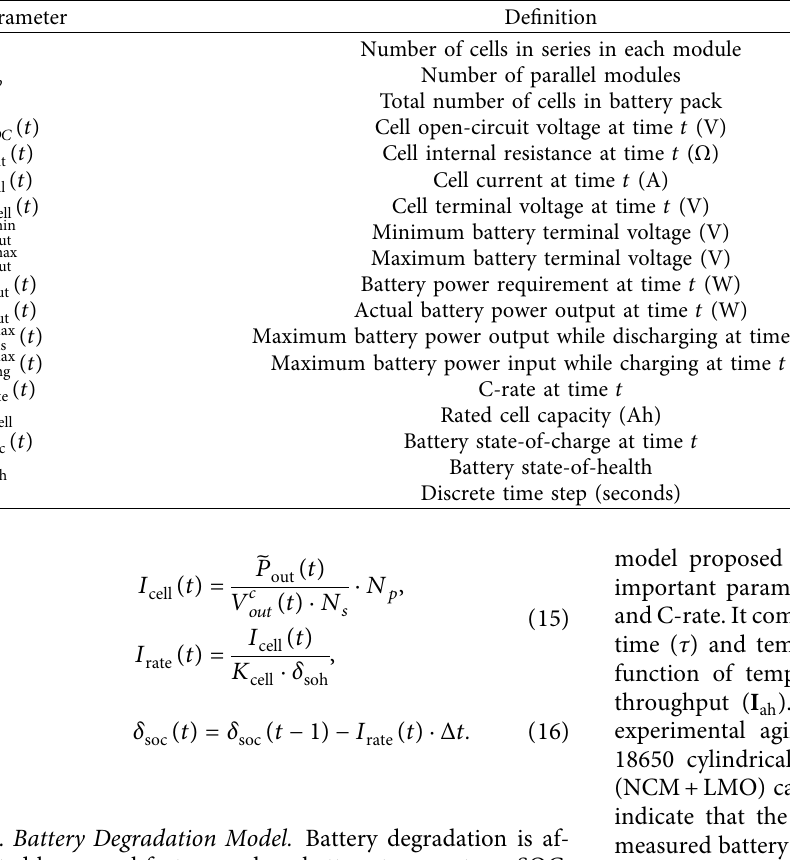
Table 3: Battery equivalent circuit model